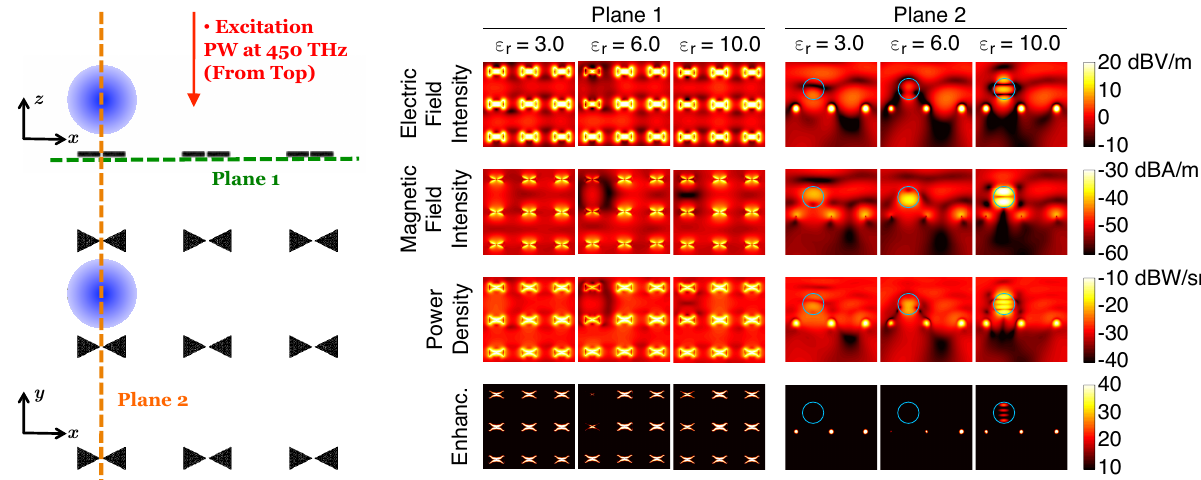
Figure 11: Near-zone characteristics of an array of 3 × 3 nanoantennas when dielectric particles (with ε = 3 . 0 , 6 . 0 , 10 . 0 ) of diameter 300 nm are located above the array. The periodicity of the array is 475 nm. The particles are 90 nm away from the top surfaces of the nanoantennas.